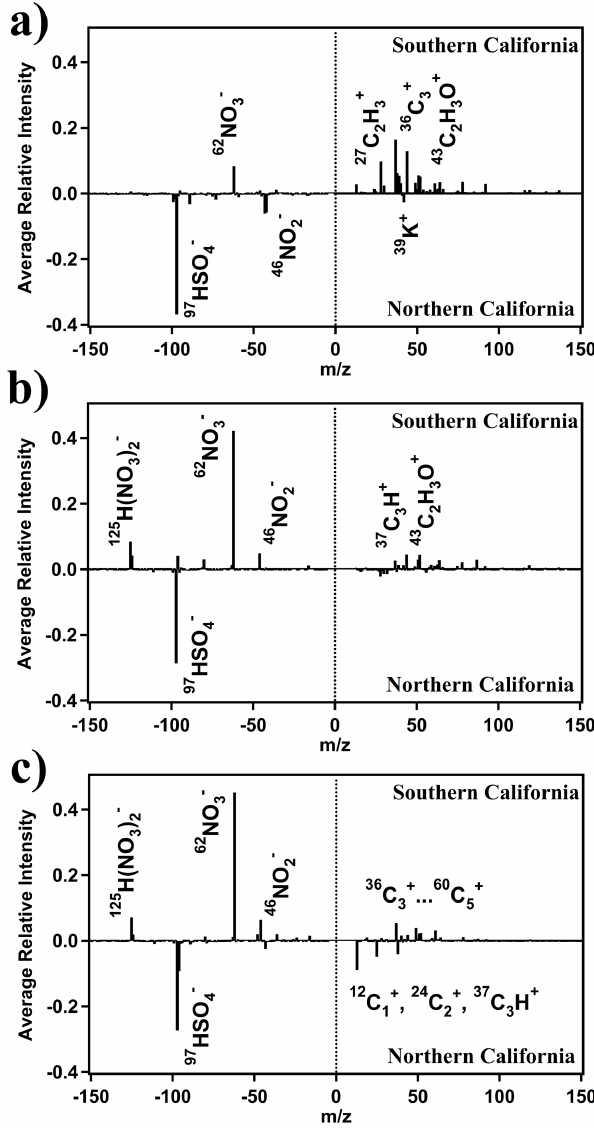
Fig. 10. Spectral difference plots of (a) BB, (b) OC, and (c) Aged Soot particles from southern (top) and northern (bottom) California. Secondary species show the greatest difference between the two re-